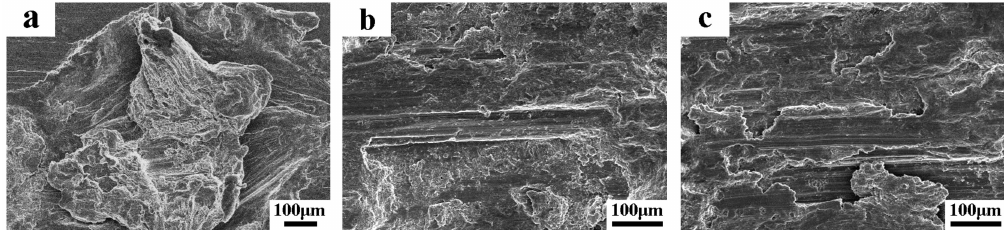
Figure 8. SEM morphologies of fretting wear scars in dry friction environment: ( a ) F n = 30 N,